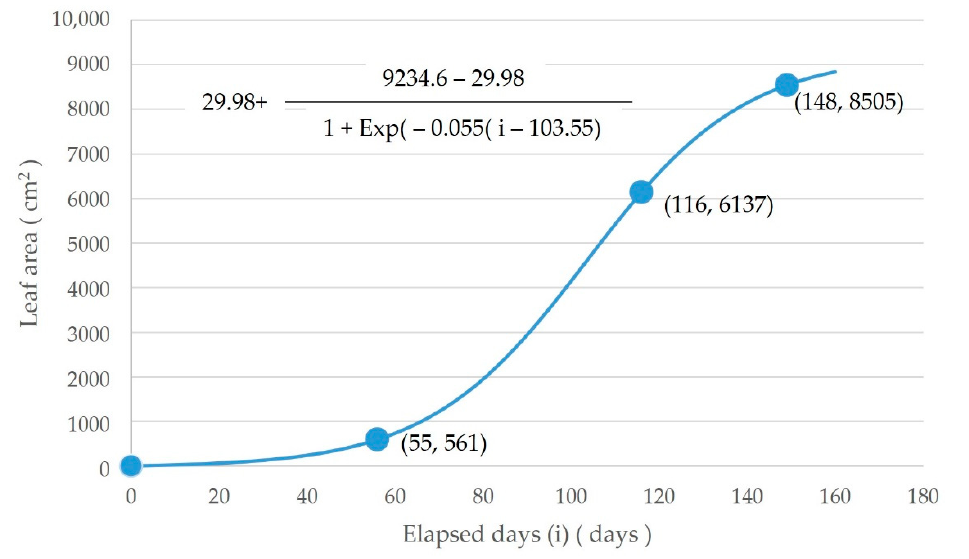
Figure 4. Elapsed day-to-day growth of leaf area starting from the exposure of seed potatoes to sunlight to the start of harvest ( D l ).